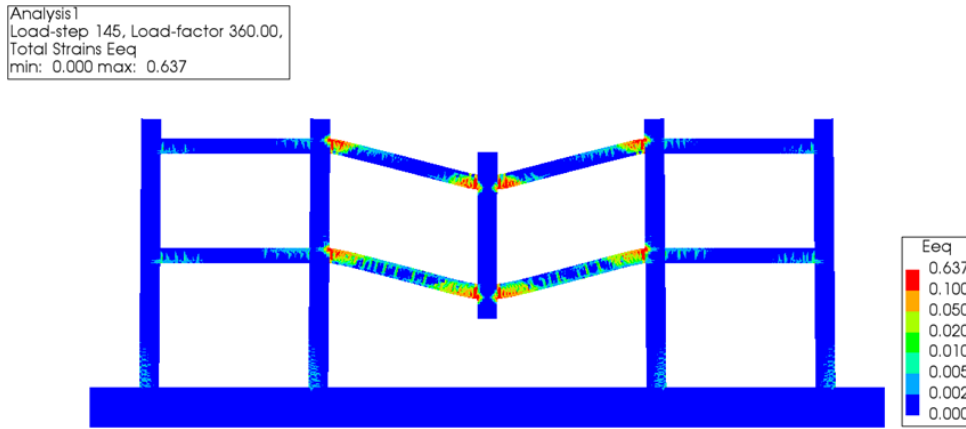
Figure 11. Numerical failure mode of two-storey frame.